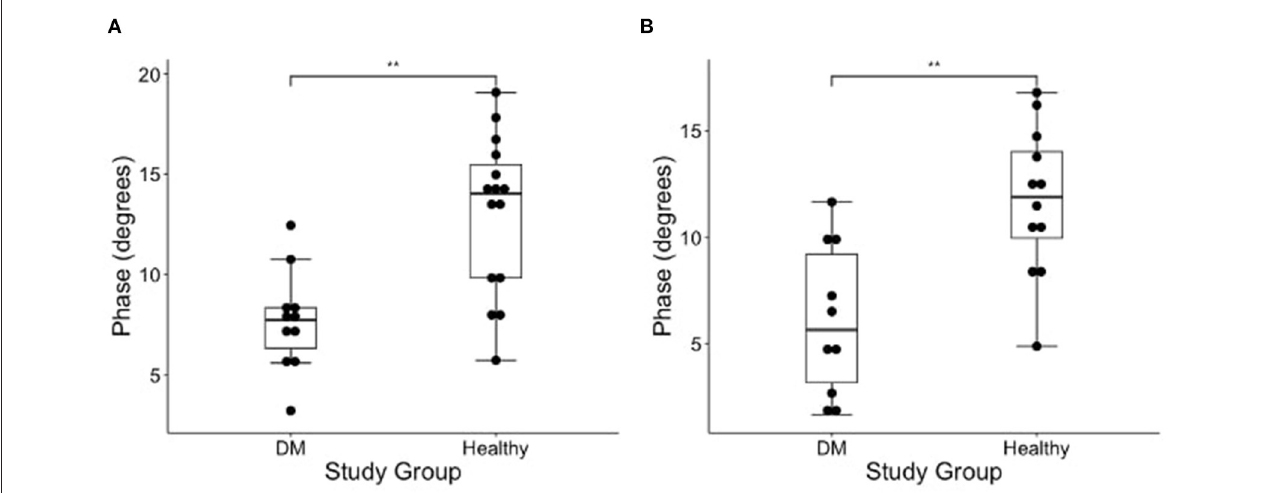
FIGURE 2 | Boxplot of the EIM phase measurements (degrees) obtained from the (A) left and (B) right gastrocnemius muscles in DM dogs and healthy dogs using Wilcoxon rank sum test. There is a significantly lower phase in the gastrocnemius of the DM affected dogs as compared to healthy control dogs in both pelvic limbs [**indicates significance; p -value 0.002 (left) and 0.001 (right)]. =